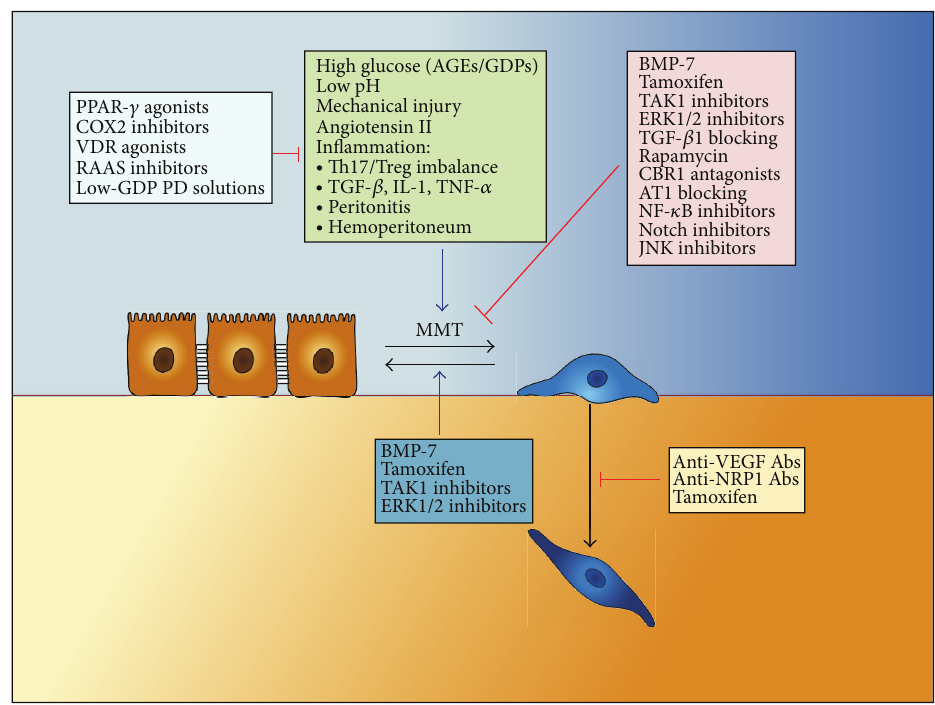
Figure 6: Therapeutic strategies for peritoneal membrane failure based on MMT. MMT in vivo results from integrated signals induced by multiple stimuli. These include high concentration of glucose and glucose degradation products (GDPs) in the PD fluids, which contribute to the formation of advanced glycation-end products (AGEs) and stimulate the mesenchymal conversion of MCs. The low pH of the dialysates and the mechanical injury during PD fluid exchanges may cause tissue irritation and contribute to chronic inflammation of the peritoneum, which promote MMT. Episodes of bacterial or fungal infections or hemoperitoneum cause acute inflammation and upregulation of cytokines and growth factors such as TGF- 𝛽 , IL-1, TNF- 𝛼 , and Angiotensin II, among others, which are strong inducers of MMT. The therapeutic strategies may be designed either to prevent or reverse the MMT itself, to decrease the MMT-promoting stimuli, or to treat MMT-associated effects such as the invasion capacity to avoid their accumulation in the compact zone. The diagram illustrates aspects related with the MMT process that can be clinically managed, alone or in combination, in order to prevent peritoneal membrane failure. See text for details.